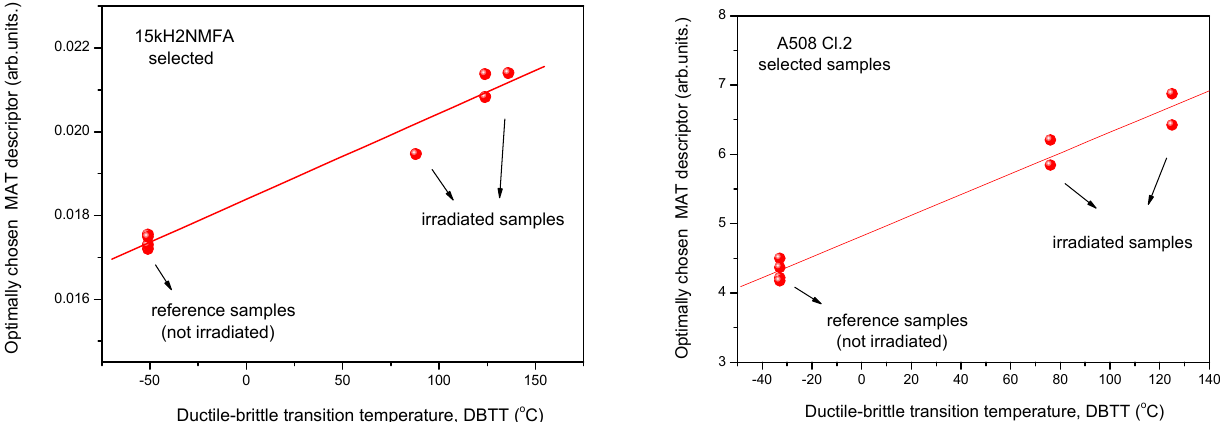
Figure 10. Measured permeability loops of A508 Cl.2 samples before irradiation. The right panel shows the magnified part of the left graph.